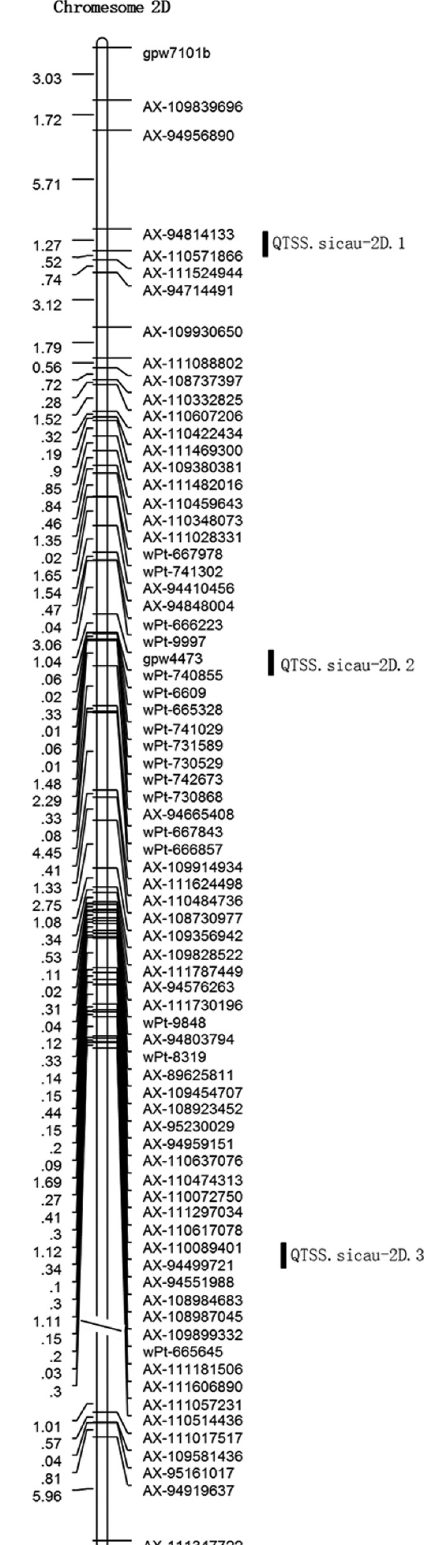
Figure2 -ChromosomallocationsofquantitativetraitlociforTSSandas- sociated markers in the SHW-L1/Chuanmai 32 recombinant inbred line (RIL) population under 6 environments. The black bar points to the LOD peak of QTL. T a